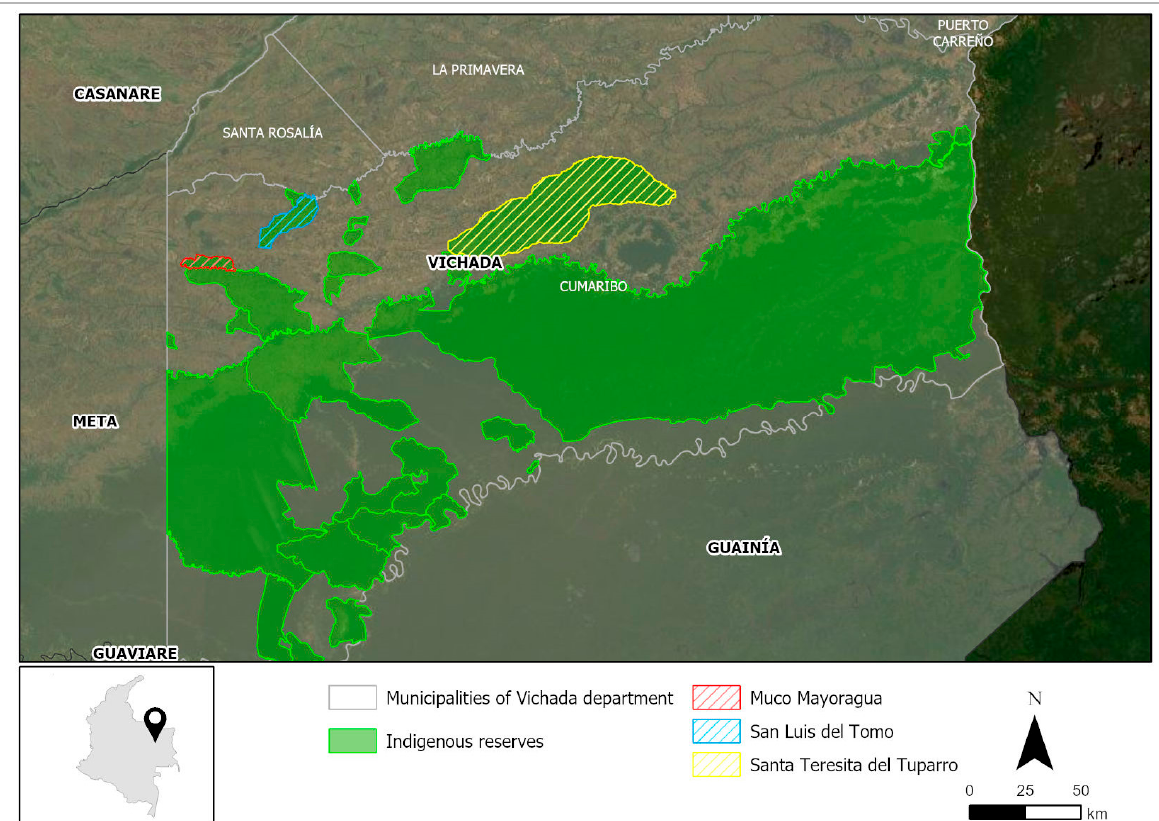
Figure 2. The three Indigenous reserves that were visited in Cumaribo: Muco Mayoragua, San Luis del Tomo, and Santa Teresita del Tuparro in the municipality of Cumaribo, 2020. Source: Land in Peace Project, Kadaster.